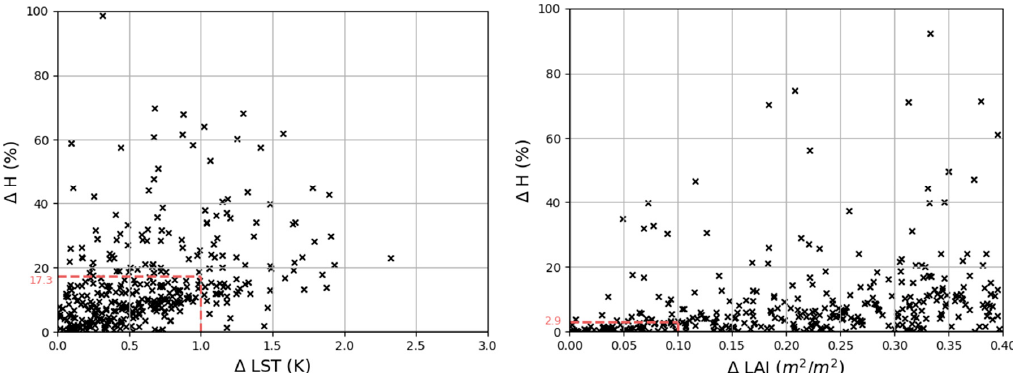
Figure 5. Scatter plots of the absolute percent change in daily aggregated H (y ‐ axis) with the associated absolute perturbation of the daily aggregated input (x ‐ axis): LST (left) and LAI (right) using TSEB ‐ DF. The median percent change in modelled H for a 1K change in LST (left) and a 0.1 m 2 /m 2 change in LAI (right) are shown as dashed red lines.